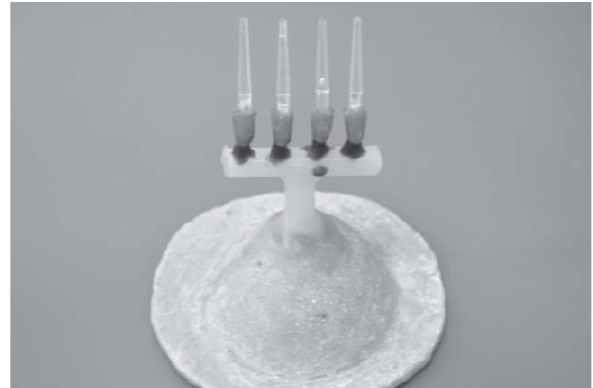
FIGURE 3- G1- 4 patterns/small ring